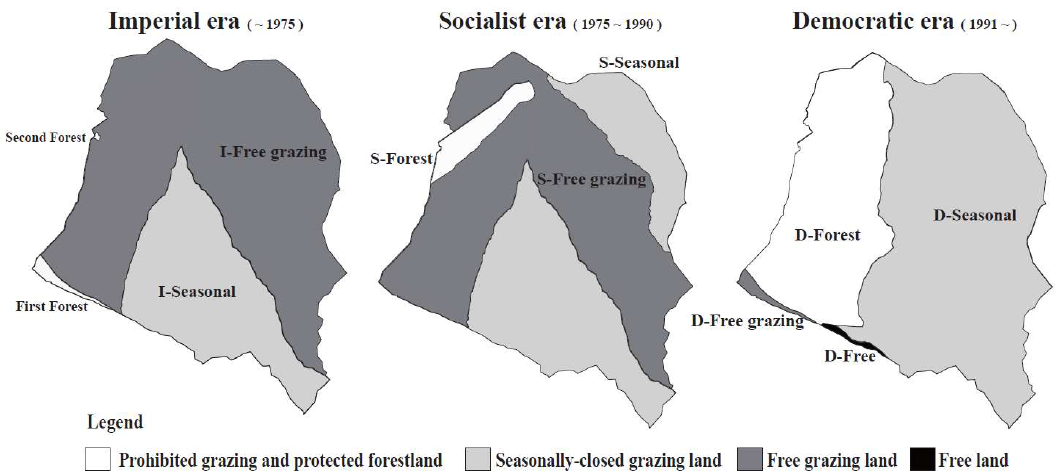
Figure 2. Changes in land management in the Adi Zaboy watershed during the imperial, socialist, and democratic eras.